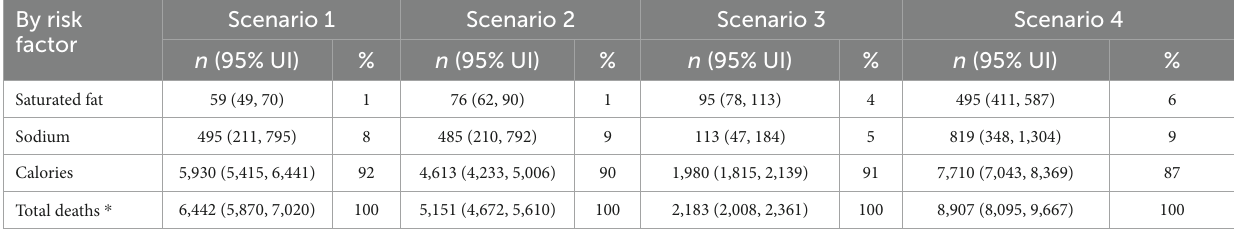
(Supplementary Table S4.1.1, S4.2.1, S4.3.1, and